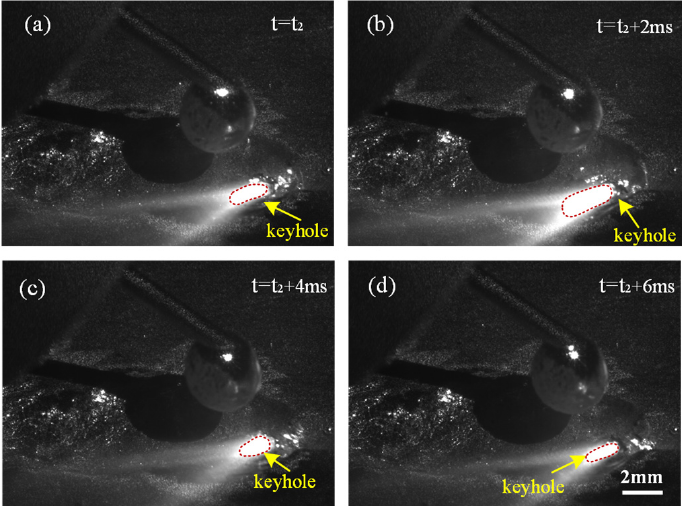
Figure 4. Experimentally observed keyhole fluctuation before the droplet transfer stage. ( a ) t = t 2 ; ( b ) t = t 2 + 2 ms; ( c ) t = t 2 + 4 ms; ( d ) t = t 2 + 6 ms.